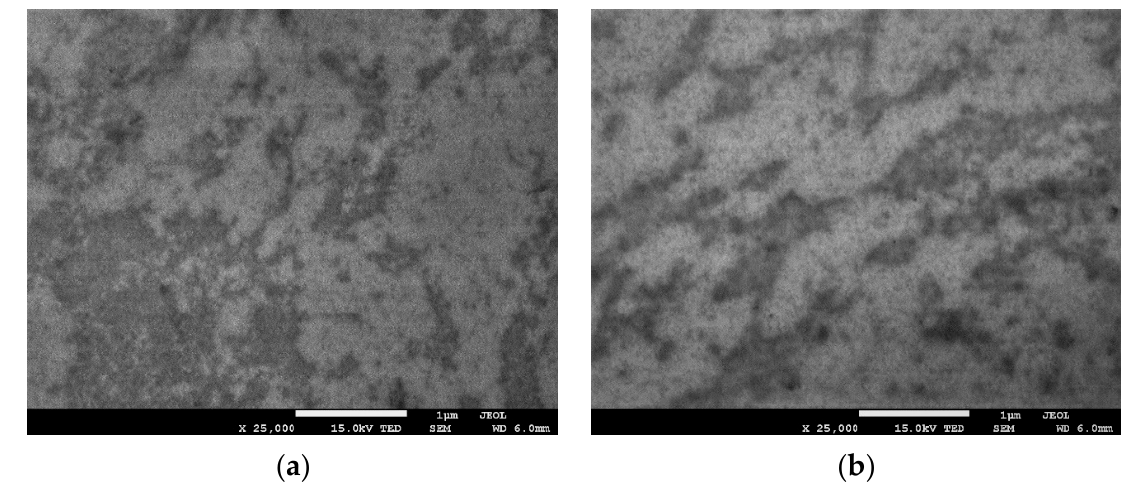
Figure 6. TEM micrograph taken at 25,000 × magnification of ( a ) thin nanocomposite I and ( b ) thin nanocomposite II. 3.8. Water Content, Solubility, and Degree of Swelling of Composites The water content in all the composites does not vary much and ranges from 8.81% to 10.92% (Table 6). A descending trend was observed for thick nanocomposites I and II, which resulted from an increase in solid content of GO incorporated in the samples. These values correspond with the thickness measurements shown in Table 7. Table 6. Water content, solubility, and degree of swelling of composites.